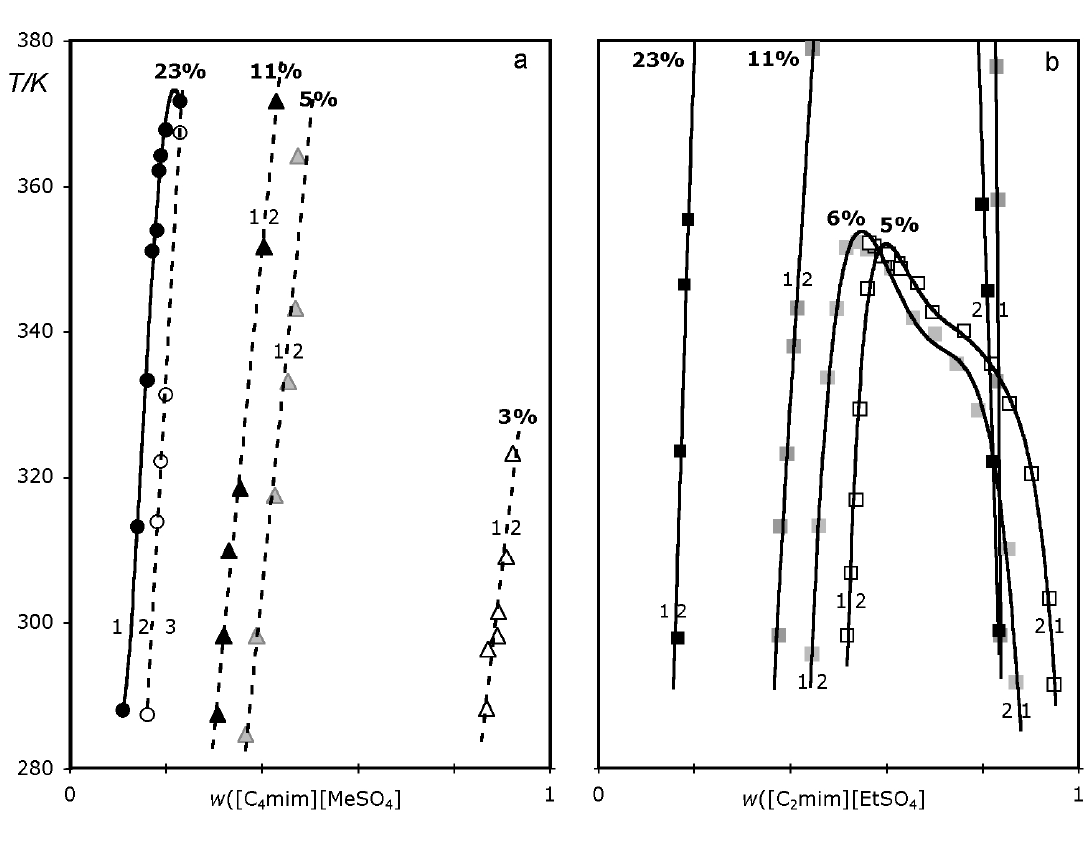
Figure 1. Cloud-point temperature as a function of ionic liquid concentration (weight fraction) in (a) K PO + [ C mim ][ Me SO ) + H O, and (b) K PO + [ C mim ][ Et SO ) + H O. In bold are the weight 3 4 4 4 2 3 4 2 4 2 percentages of K PO in the initial (K PO + H O) solutions. The 1, 2 and 3 numerals on each side of 3 4 3 4 2 the lines represent the number of phases at equilibrium. The solid lines indicate transitions to ABS; the dashed lines the occurrence of K PO 3 4